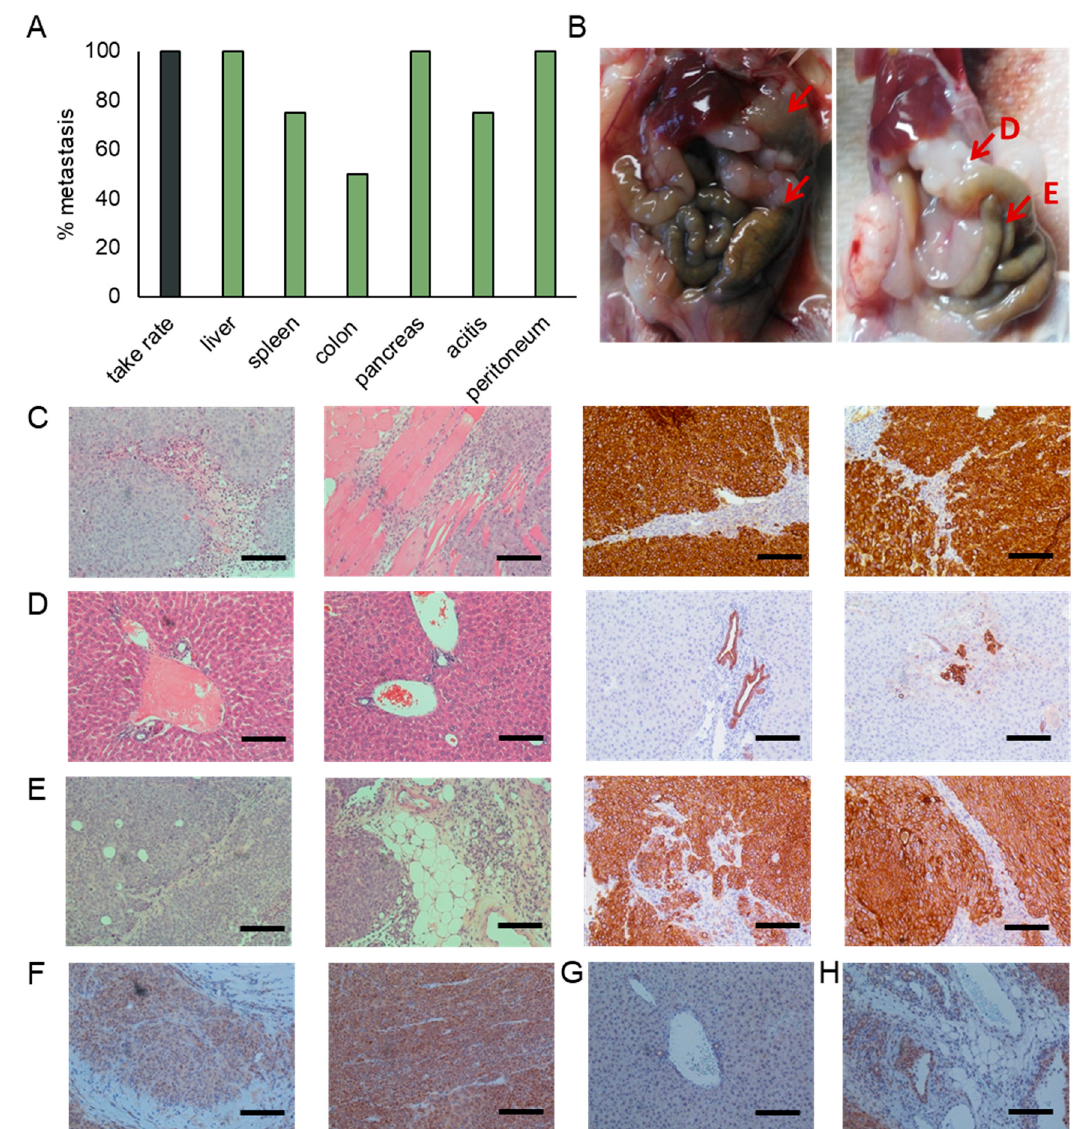
Figure 5. Characterization of the CTC patient derived xenograft (PDX). ( A ) Injection of the CTC cell line derived from patient 3 into the flanks of nonobese diabetic/severe combined immunodeficiency (NOD/SCID) mice resulted in the development of subcutaneous tumors in all injected mice. Additionally, we observed widespread metastases and the development of ascites. Percentages represent the percent of animals having metastasis to that site. ( B ) Representative images of mice showing metastases in the liver, peritoneum, colon and pancreas. Representative images of sections stained for cytokeratin and H&E of ( C ) subcutaneous tumors, ( D ) liver metastases, and ( E ) pancreatic metastases. Representative images of sections stained for Smad4 of ( F ) subcutaneous tumors, ( G ) liver metastases, and ( H ) pancreatic metastases. (Scale bar = 100 μ m).